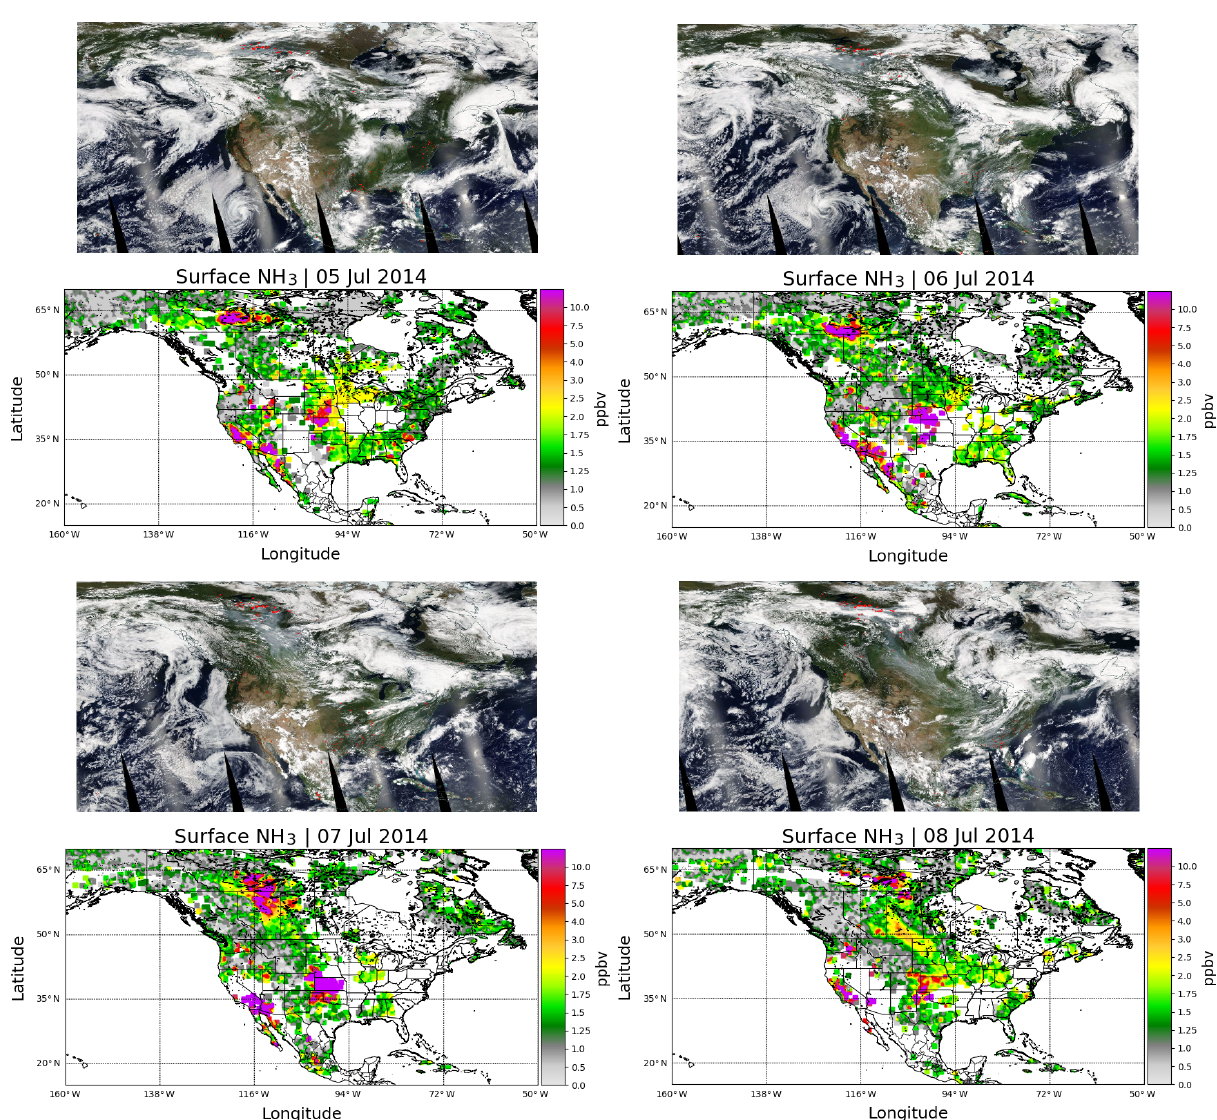
Figure 7. Single-day maps of MODIS true-colour visible imagery and corresponding CrIS surface NH 3 observation for four consecutive days from 1 to 4 June 2016. Overlaid on the MODIS visible images are the red thermal hotspots indicating forest fire locations. (MODIS images obtained from NASA Worldview – https://worldview.earthdata.nasa.gov/, last access: 19 February